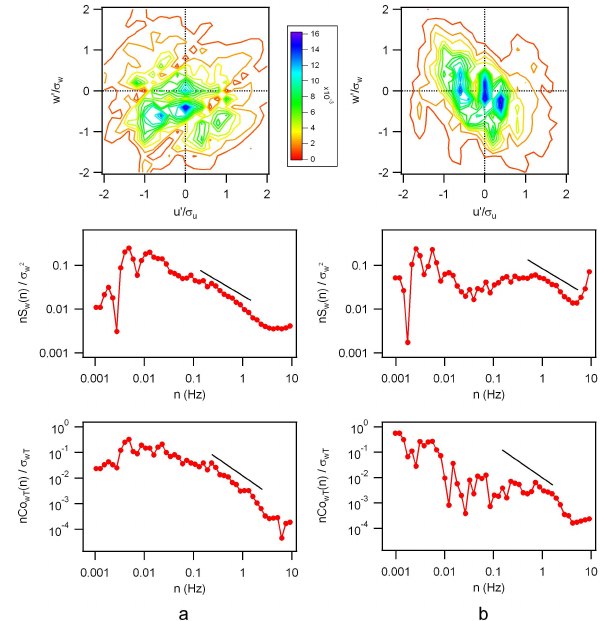
Fig. 12. Quadrant plots of normalised u and w fluctuations (top panels), frequency weighted power spectra of w (middle panels) and co-spectra of w and temperature (bottom panels) for ground- level trunk space data taken at (a) 07:00 on the 16th July, and (b) 14:00 on the 15th July 2008. The solid black lines on the spectra and co-spectra represent the theoretical inertial subrange slopes of n − 2 / 3 and n − 4 / 3 respectively (Kaimal et al., 1972).